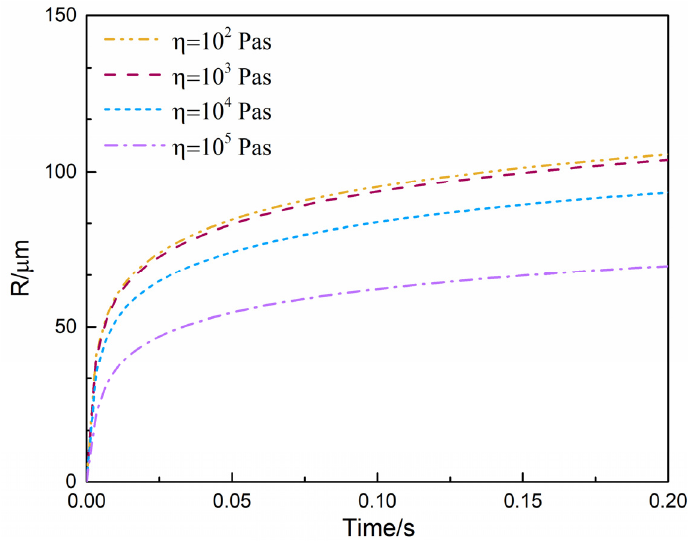
Figure 10. Effect of shear viscosity ( η ) on predicted bubble growth behaviors.